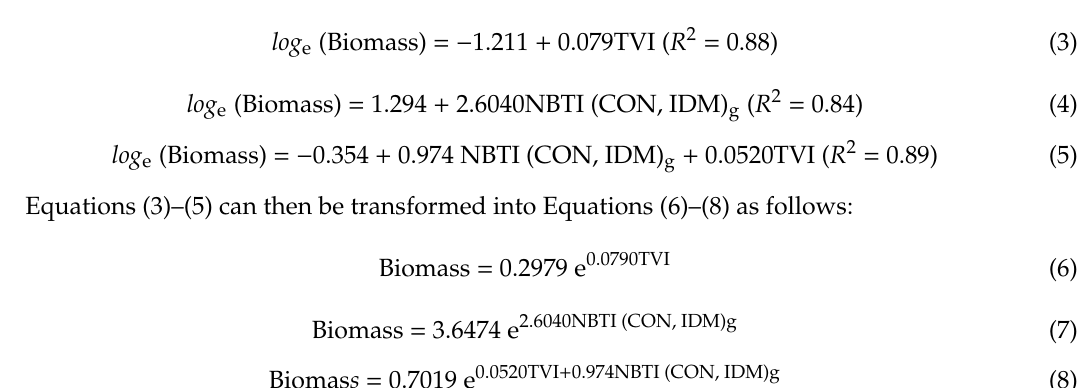
Table 5. Calibration and validation results for the cotton biomass estimation models designed using textural indices. During model calibration, linear, logarithm, exponential, and power models were used to design model, with the best results shown here.